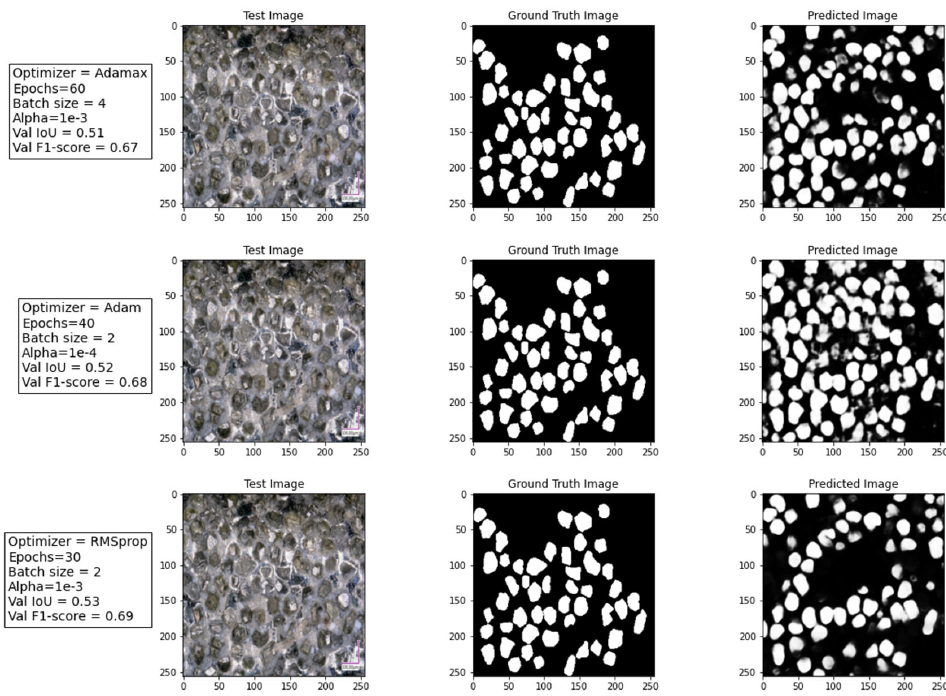
Figure 8. DGW test images of type II, associated mask and prediction for each optimizer.